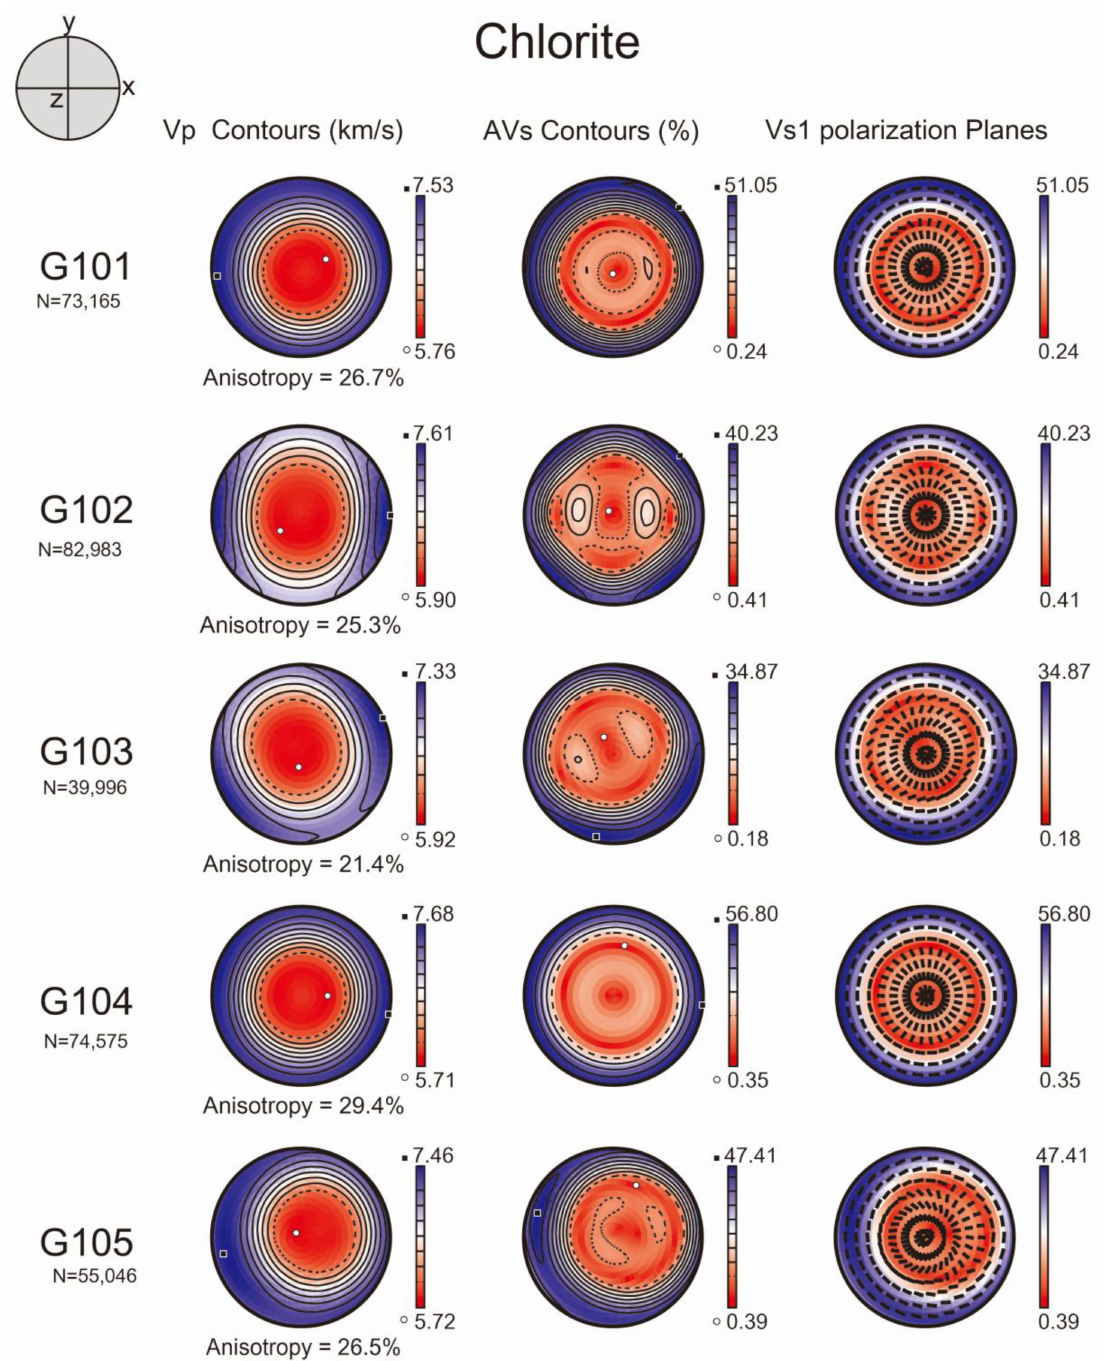
Figure 7. Seismic properties of chlorite calculated from LPO and elastic constant. The P-wave velocity (Vp), amplitude of the shear-wave anisotropy (AVs), and polarization direction of the faster shear wave (Vs1) are plotted in the lower hemisphere using an equal-area projection. E–W direction of each figure corresponds to stretching lineation (X), and Z is normal to the foliation. N = number of data